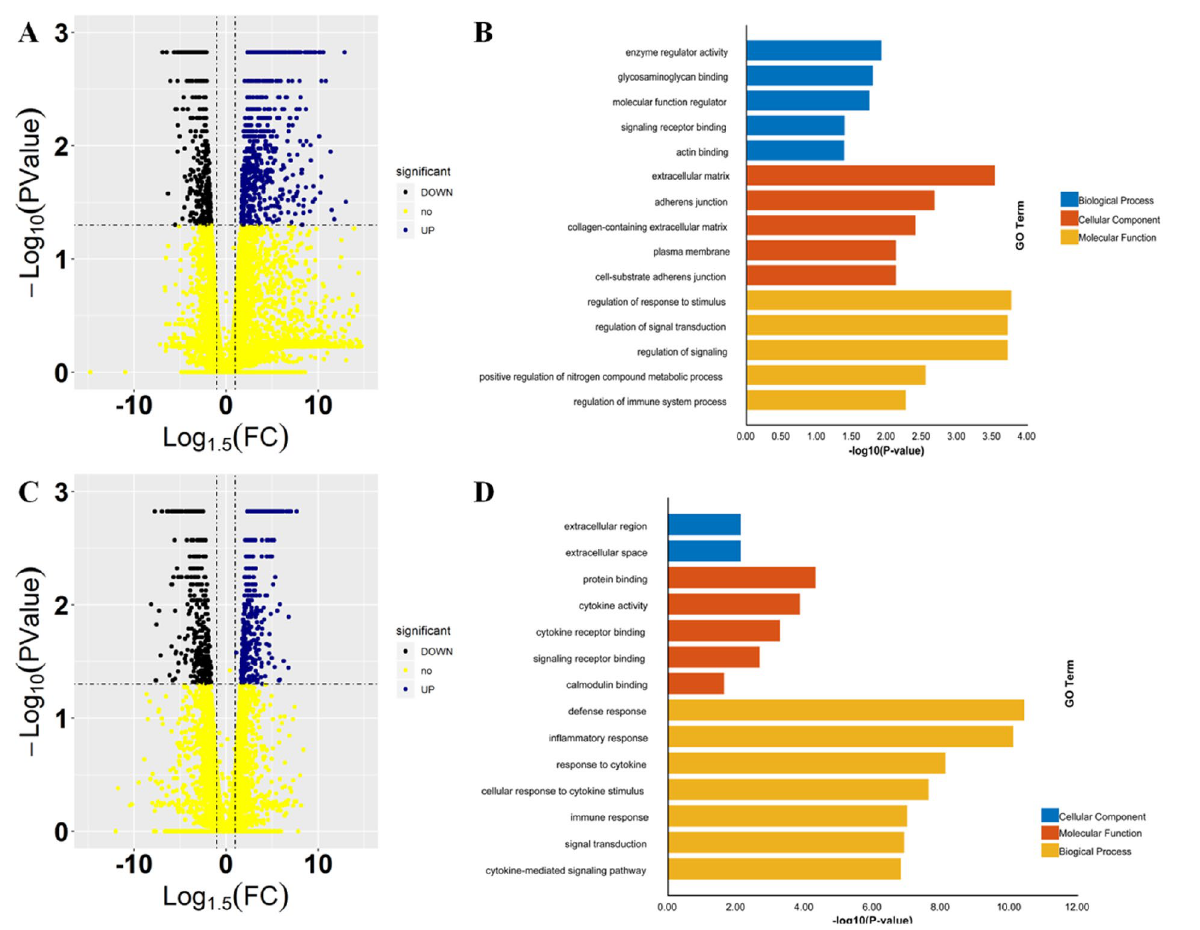
Figure 5. Differentially expressed genes and functional enrichment analysis of BAM infected by MTB and MB. ( A , C ) Volcanic map of gene expression in BAM after MB ( A ) and MTB ( B ) infections (Log1.5FC < − 1.0 or > 1.0; q-value < 0.05). ( B , D ) All differentially expressed genes infected by MB ( B ) and MTB ( D ) were divided into three GO categories (i.e., cell composition, molecular function, and biological process). Transcriptomic datasets were collected from published articles, as shown in Table